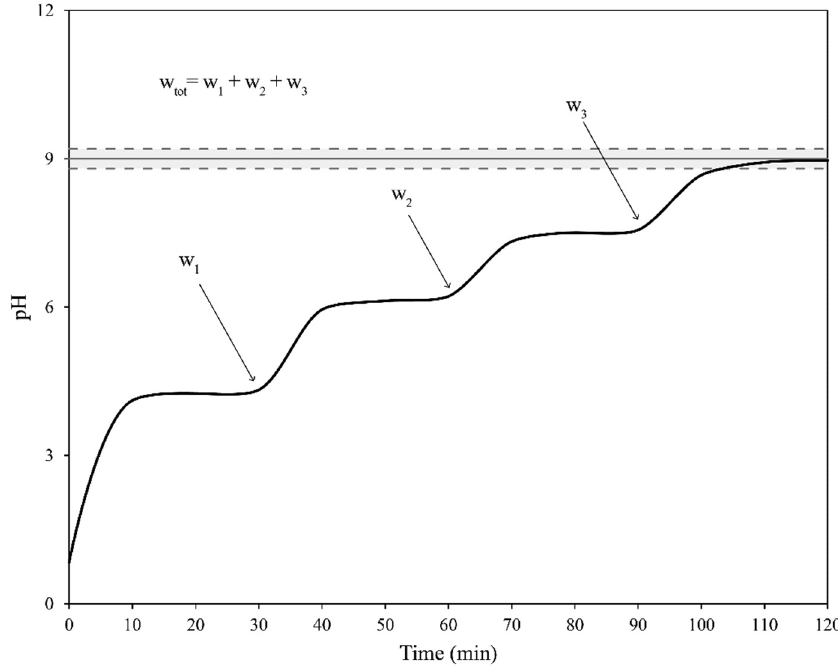
Figure 3. A schematic representation of a stepwise dosing trial with three additions of